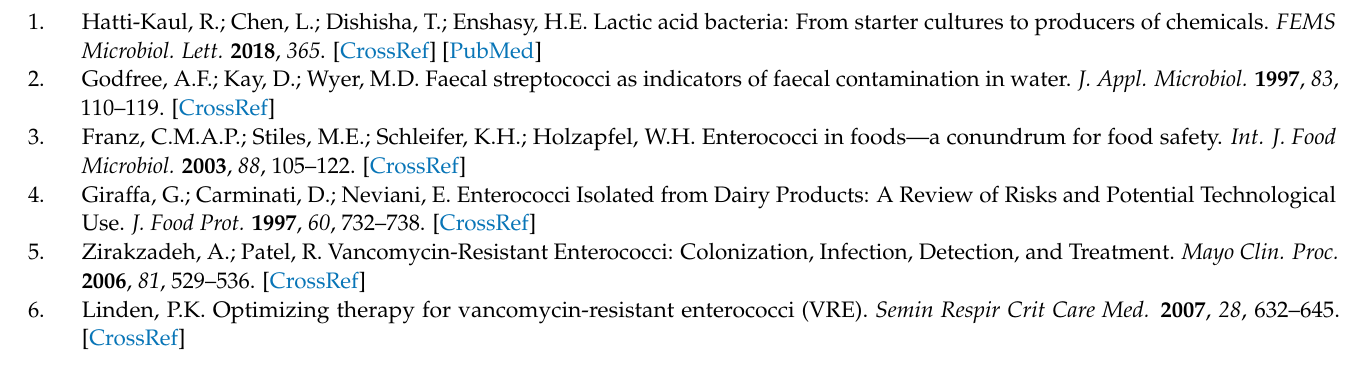
Supplementary Materials: The following are available online: Figure S1. ESI-MS spectrum of the unknown byproduct ( 3 ) obtained during the synthesis of compound; Figure S2. MS/MS spectrum of the unknown byproduct ( 3 ); Figure S3. Enlargement of the MS/MS spectrum and fragmentation pattern of structure proposed for the 11 unknown byproduct; Figure S4. Comparison of the isotopic distribution of the unknown byproduct ( 3 ) with the [C26H23FN4O+1]+ 13 pattern; Figure S5. IR spectrum of the unknown product ( 3 ); Figure S6. 1HNMR spectrum of amine; Figure S7. IR spectrum of amine 2 ; Figure S8. ESI-MS spectrum of amine 2 ; Figure S9. 1HNMR spectrum of aldehyde 4 ; Figure S10. IR spectrum of aldehyde 4 ; Figure S11. ESI-MS spectrum of aldehyde 4 ; Figure S12. 1HNMR spectrum of imine 3 ; Figure S13. IR spectrum of imine 3 ; Figure S14. ESI-MS spectrum of imine 3 ; Figure S15. Packing diagram for 2 , showing intra- and intermolecular N-H · · · N hydrogen bonds in black and 25 intermolecular interactions C-H · · · O in red and C-H · · · F in green; Figure S16. Part of the crystal structure of 3 two-dimensional structure formed via intermolecular interactions 27 C-H · · · O in red and C-H · · · F in green. The dashed line indicate intramolecular N-H · · · N (black) hydrogen bonds. 28 Symmetry codes: (i) x + 1, y, z − 1; (ii) − x + 1, y − 1/2, − z + 1/2; (iii) − x, y − 1/2, − z + 3/2; Table S1. Selected crystal data and structure refinement details of compounds 2 and 3 ; Table S2. Comparison of selected geometrical parameters of compounds 2 and 3